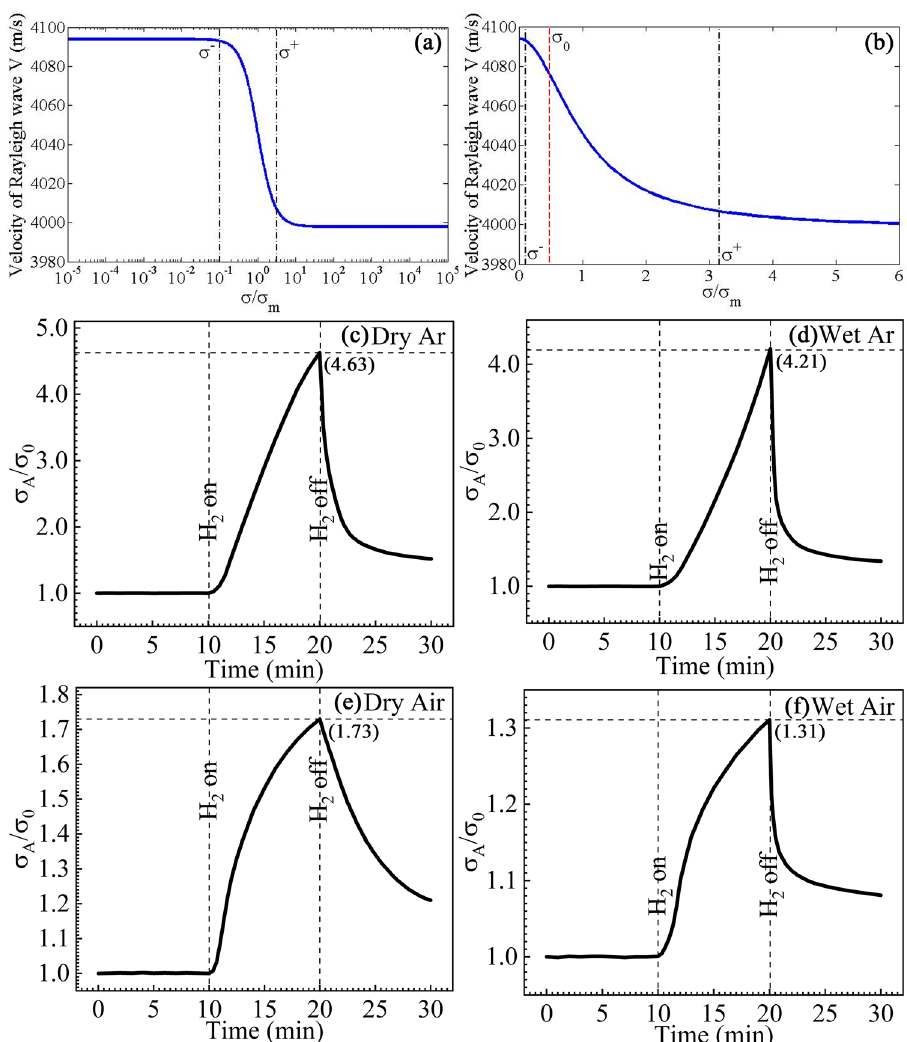
Figure 4. Conductivity variation of the sensor towards H 2 . ( a , b ) The velocity V of the Rayleigh wave transmitting in the sensor versus the normalized surface conductivity σ (cid:31) σ m . It is observed that the Rayleigh wave velocity varies rapidly with the conductivity in a narrow conductivity window, indicating a high conductivity sensitivity. ( c , d ) Responses of the conductivity of the sensor to 100 ppm H 2 mixed in ( c ) dry argon and ( d ) argon with a relative humidity of 60%. ( e , f ) Responses of the conductivity of the sensor to 1000 ppm H 2 mixed in ( e ) dry air and ( f ) air with a relative humidity of